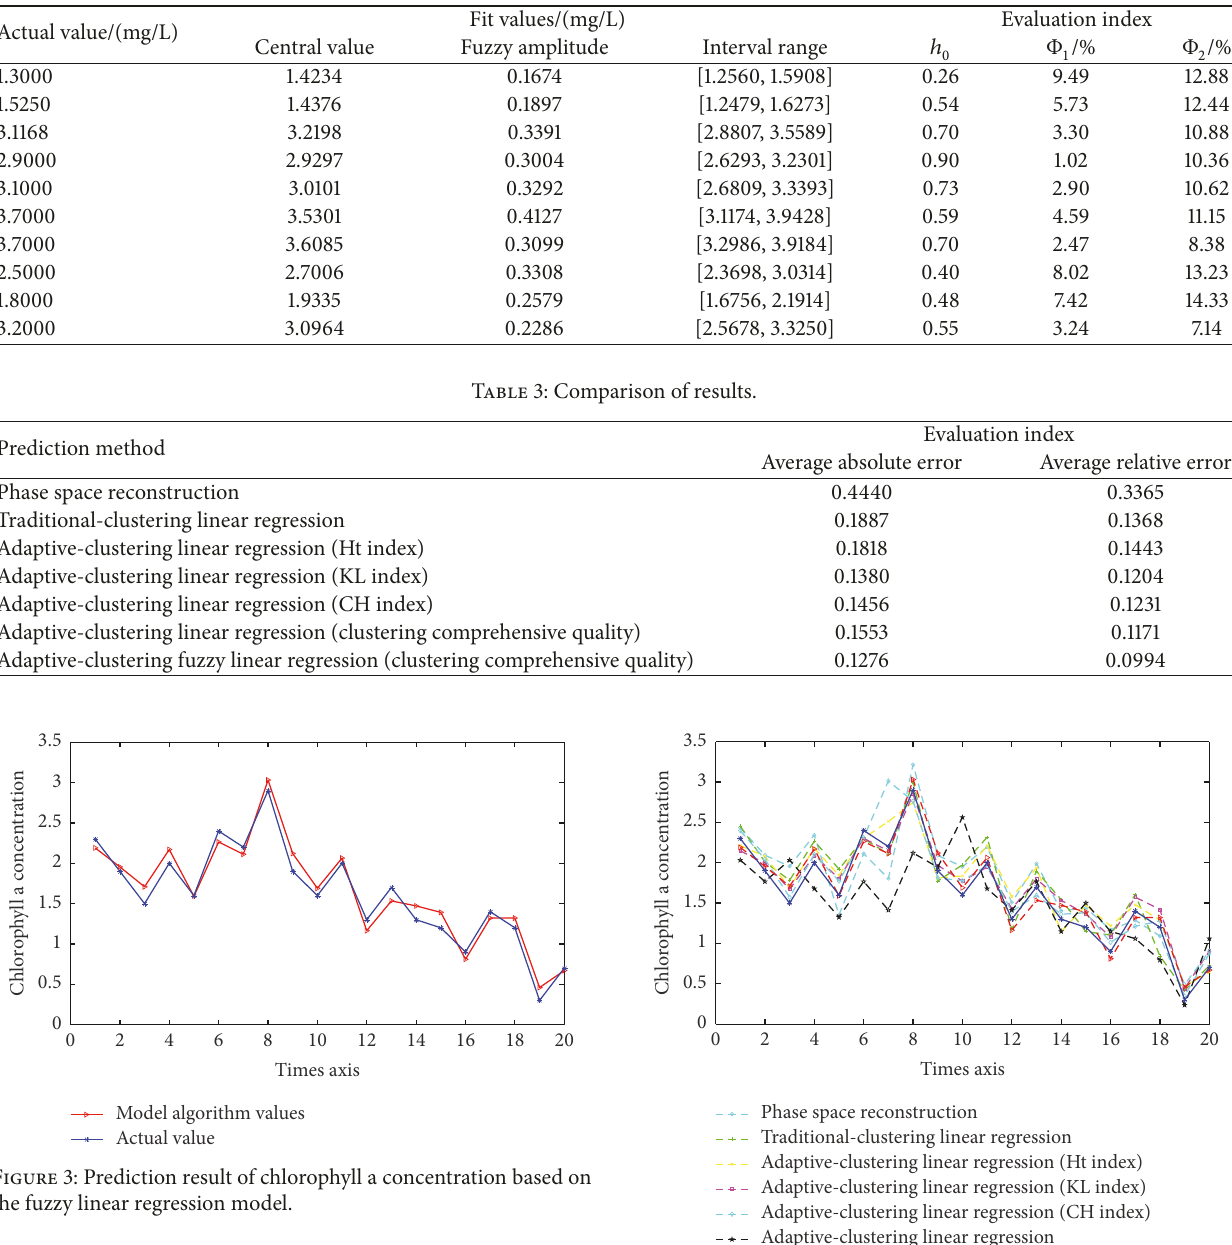
Table 2: Predicted values and actual values.